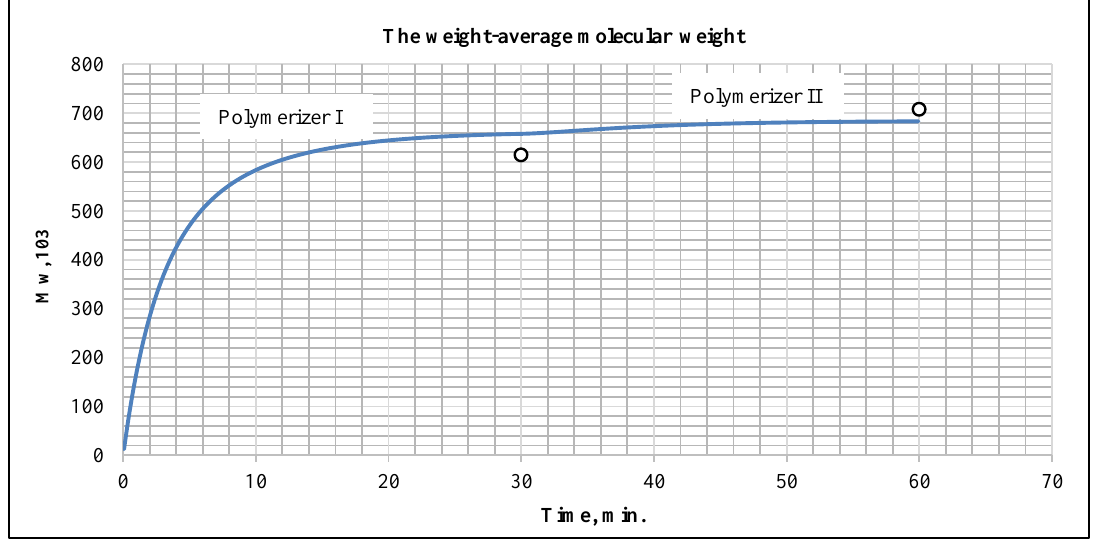
Figure 6. The dependence of the calculated weight-average molecular weight on time for polyisoprene on the catalytic system 𝑻𝒊𝑪𝒍 𝟒 -TIBA-Pip-DFO (line denotes the results of calculations, dots show the results of a laboratory